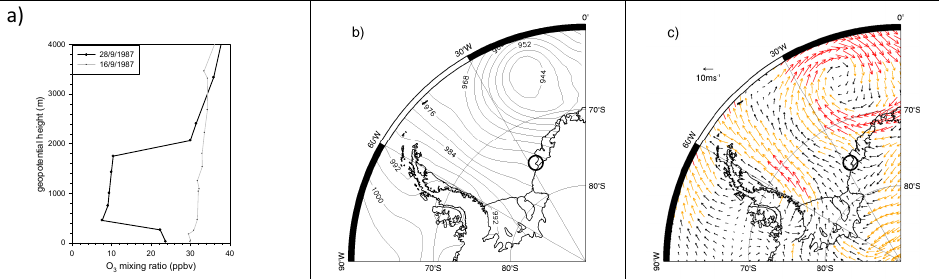
Fig. 15. (a) Ozonesonde measurements on 28 September 1987 compared with an un-depleted profile for the middle of the same month; (b) mean sea level pressure on 27 September 1987 (noon); (c) 10-m wind vectors on 27 September 1987 (noon) – wind speeds identified as: black = < 8ms − 1 ; orange = 8 to 12ms − 1 ; red = > 12ms − 1 . Halley is marked by the black circle on the plots.